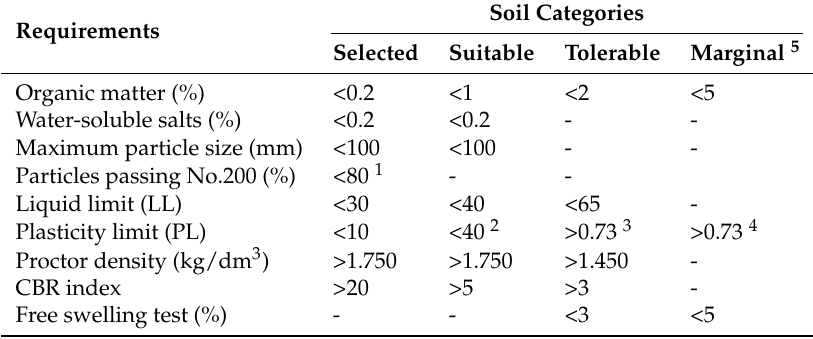
Table 1. PG-3 technical requirements for classified soils used in the construction of road foundations.